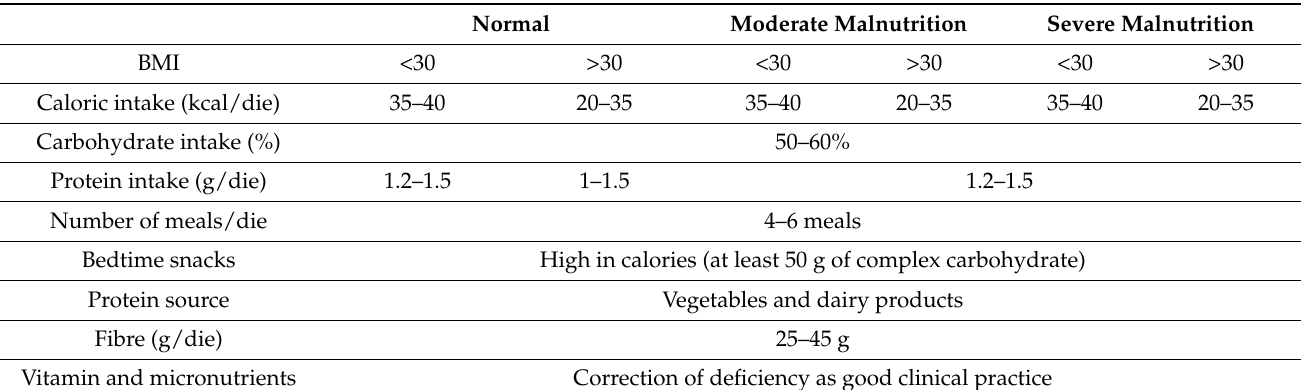
Table 1. Dietary recommendations for patients with